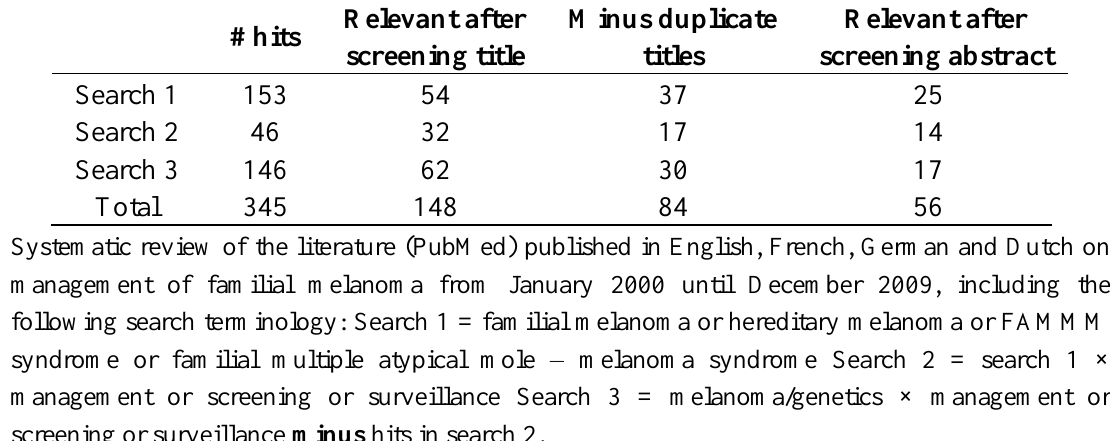
Table 2. Systematic review of the literature on management of familial